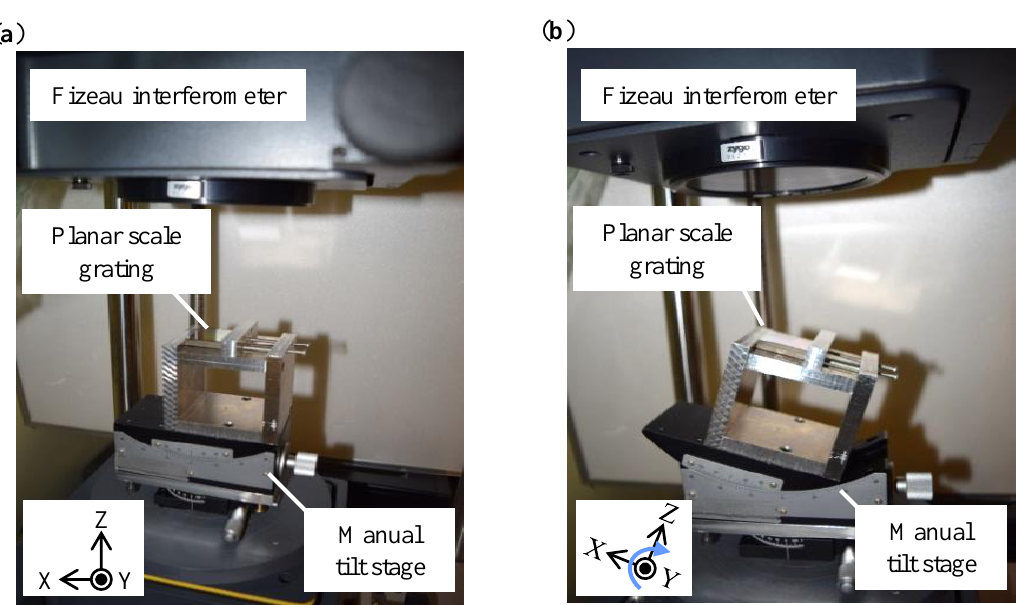
Figure 4. Photographs of measurement of the wavefronts of the diffracted beams. ( a ) 0th-order diffracted beam; ( b ) X -directional +1st-order diffracted beam.